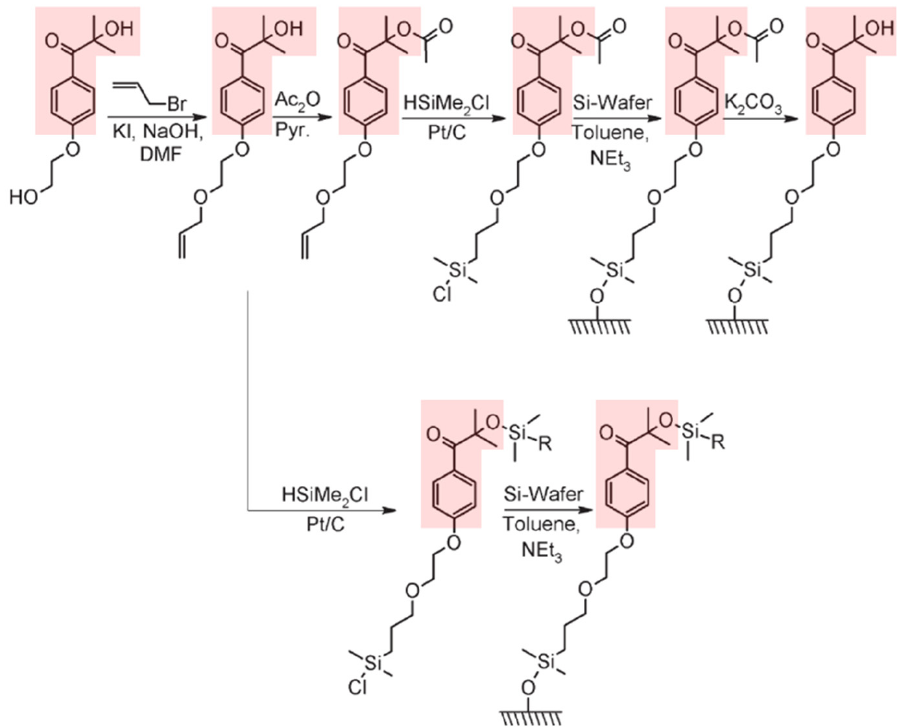
Figure 3. Two synthesis pathways to attach type I initiators onto silicon surfaces (slightly modified from ref. [28]; the photosensitive moiety is labeled in red).